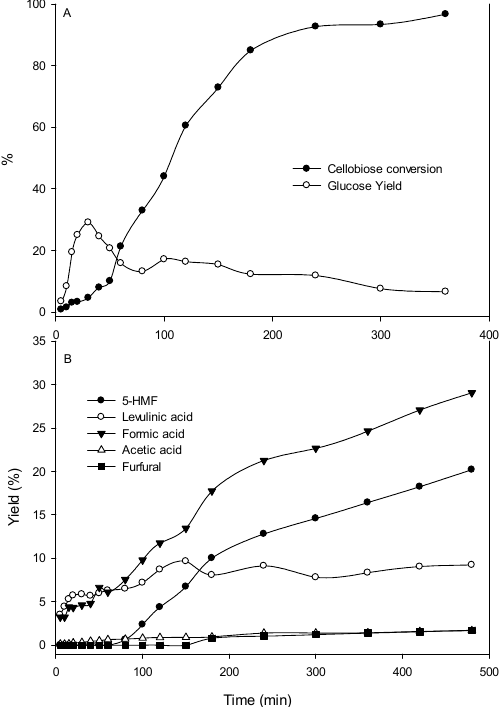
Figure 3. Reaction results of cellobiose catalyzed by [TMG]BF 4 (( A ) The cellobiose conversion and glucose yield in the conversion of cellobiose to 5-HMF; ( B ) The yield of the products catalyzed by [TMG]BF 4 ). Conditions: cellobiose (0.5 g), [TMG]BF 4 (0.25 g), dimethylsulfoxide (60 mL), 160 °C.